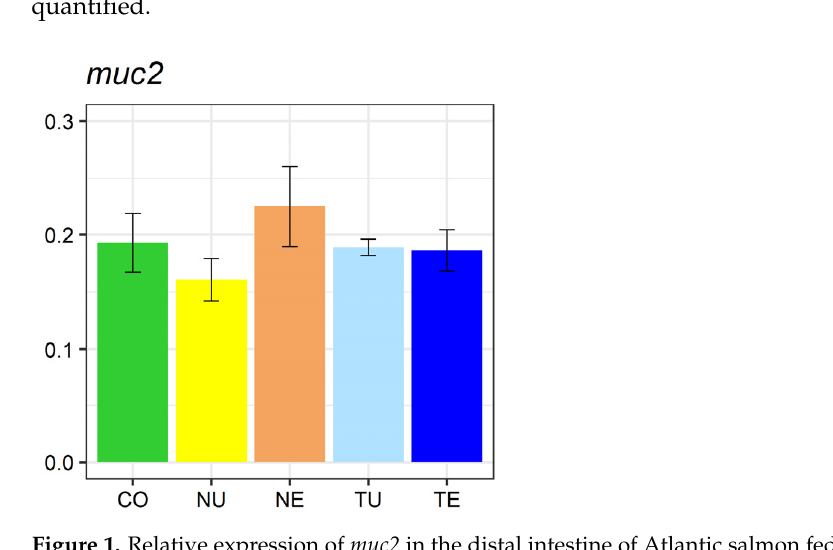
Figure 1. Relative expression of muc2 in the distal intestine of Atlantic salmon fed on different diets (CO, NU, NE, TU, TE) (n = 4 per